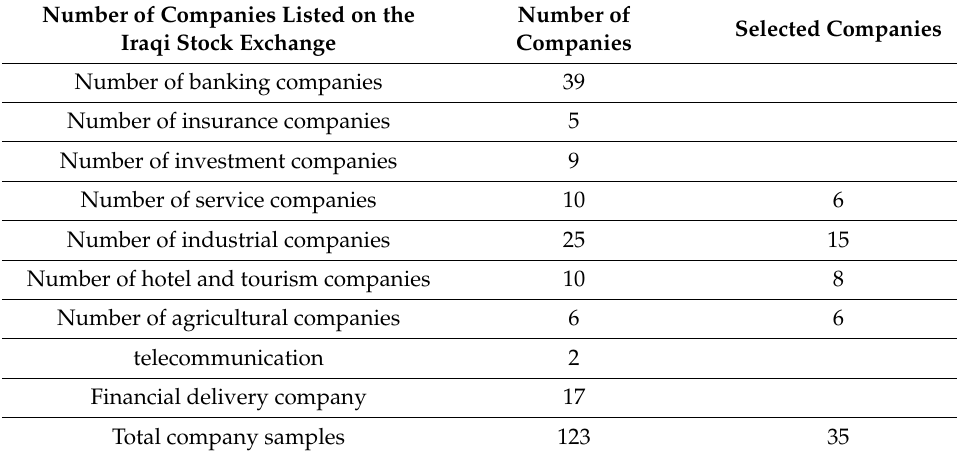
Table 1. The number of companies in the statistical community and application of conditions for sample